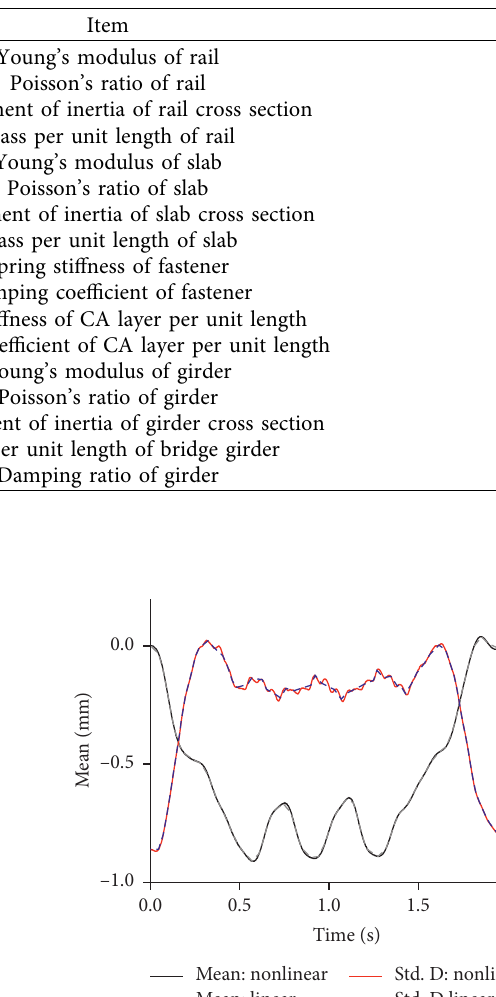
Table 3: Properties of the track-bridge.